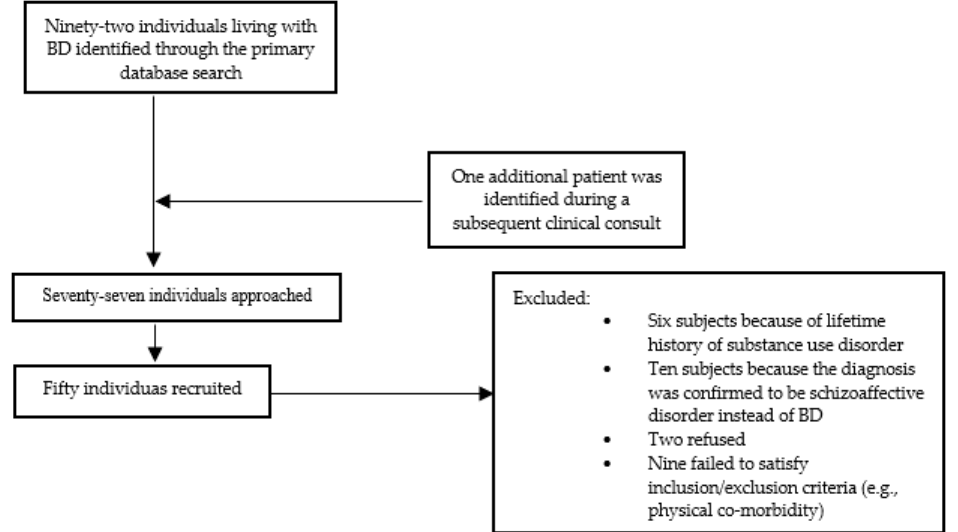
Figure 1. Summary of the recruitment process.